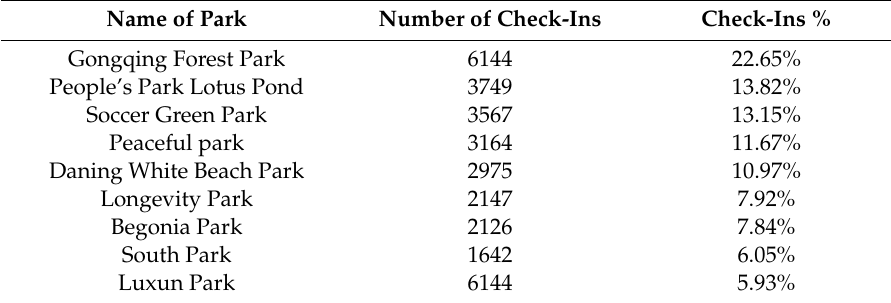
Table 4. Number of check-ins in the famous parks.